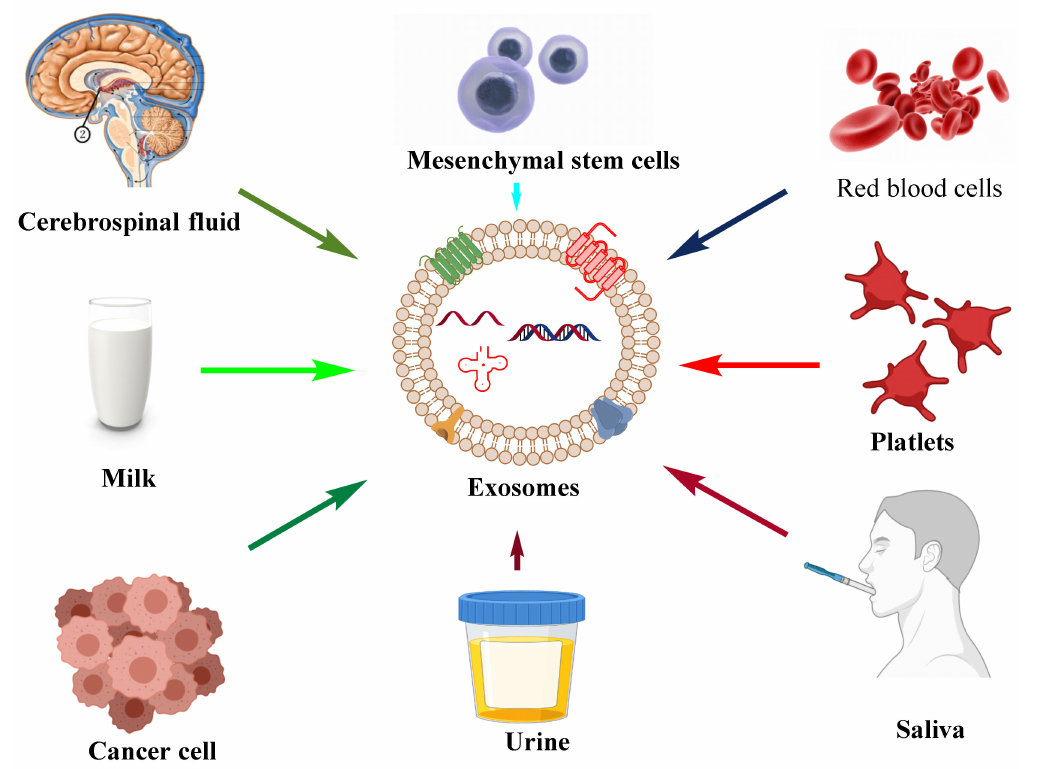
Figure 2. Different sources, viz., urine, saliva, cancer cells, platelets, milk, cerebrospinal fluid, mesenchymal stem cells, and red blood cells majorly reported for the isolation of exosomes and their use in diagnosis and drug